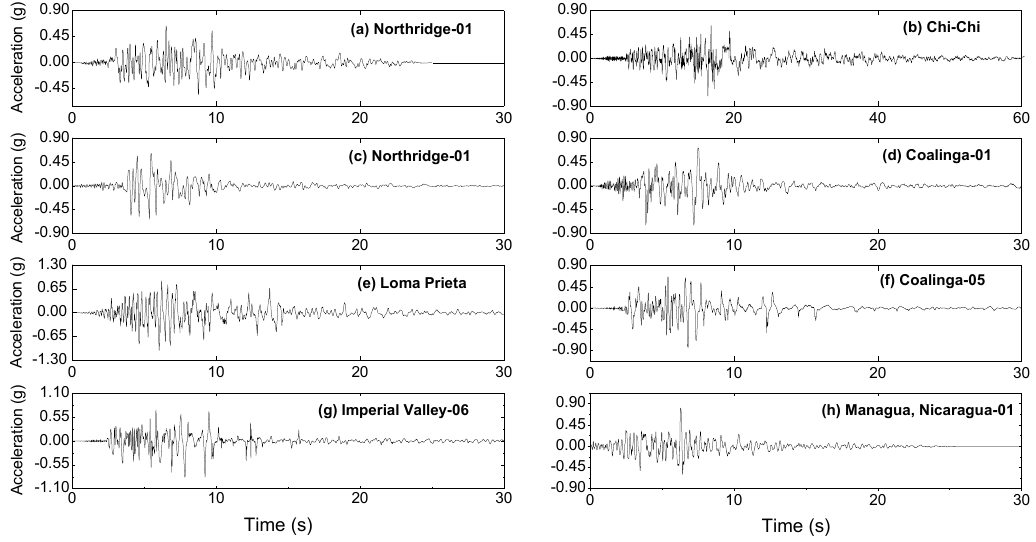
Figure 9. Another set of time history recommendations for Taipei (site a) with the basin effect taken into